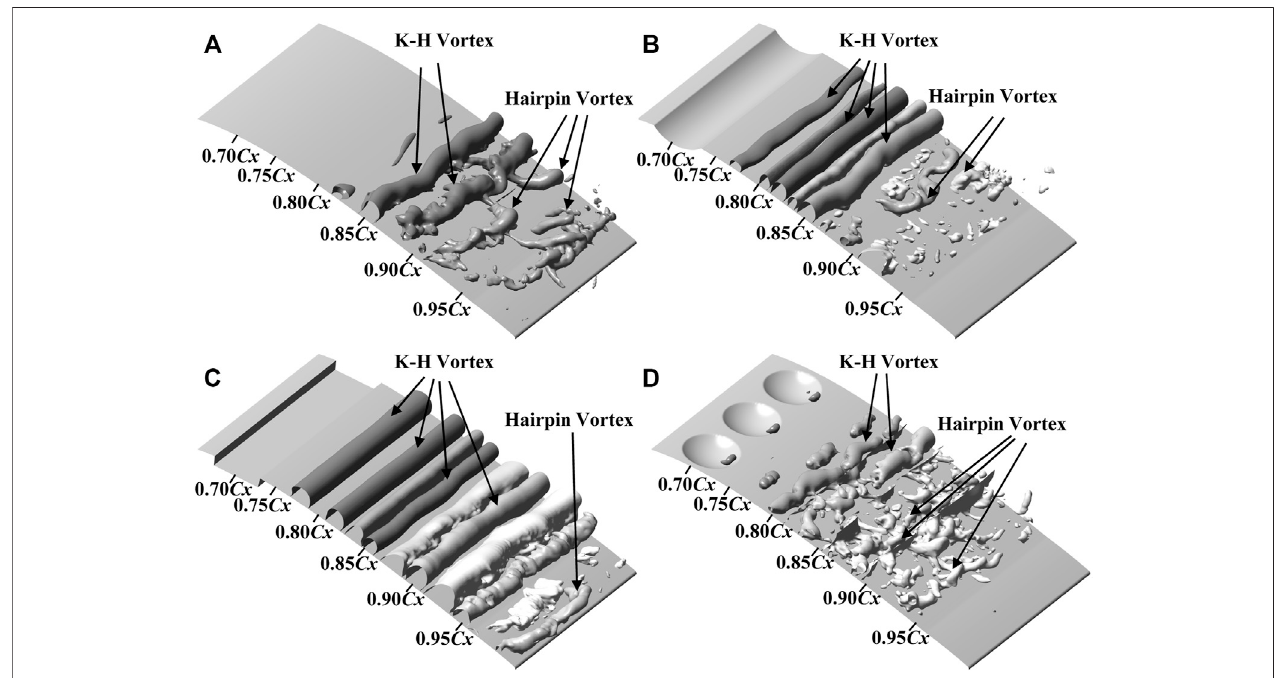
FIGURE 12 | Vortex structures in the separation bubble identi fi ed by pressure iso-surfaces: (A) baseline; (B) U-shape; (C) rectangular shape; (D) dimple.